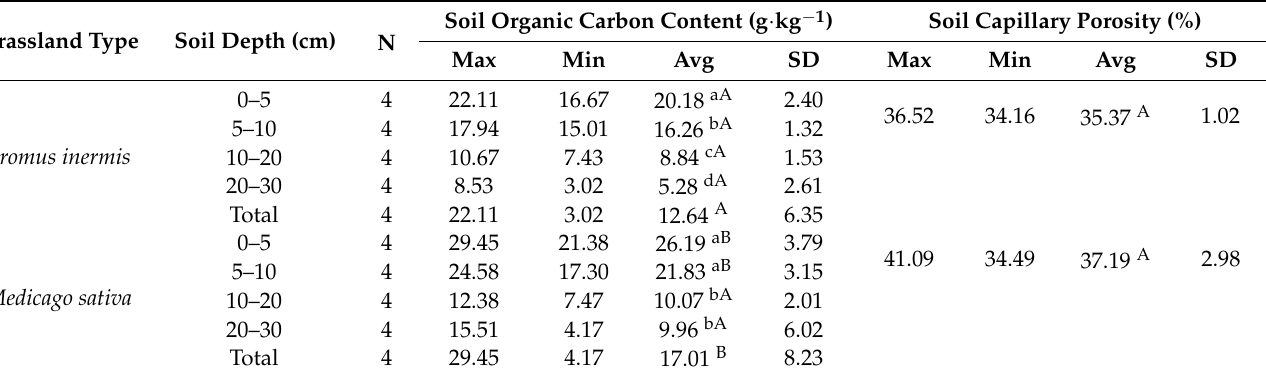
Table 3. Soil organic carbon content and soil capillary porosity in Bromus inermis and Medicago sativa